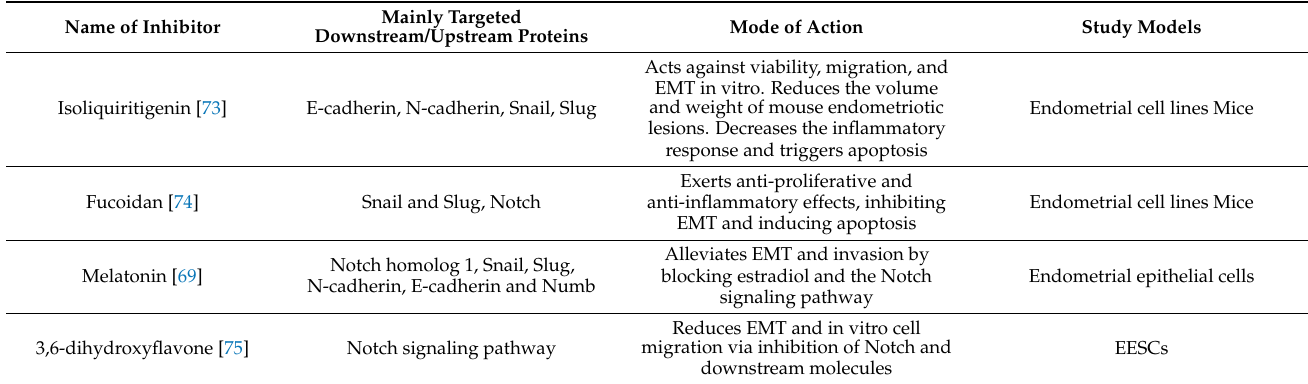
Table 7. Pharmacological inhibitors targeting EMT.